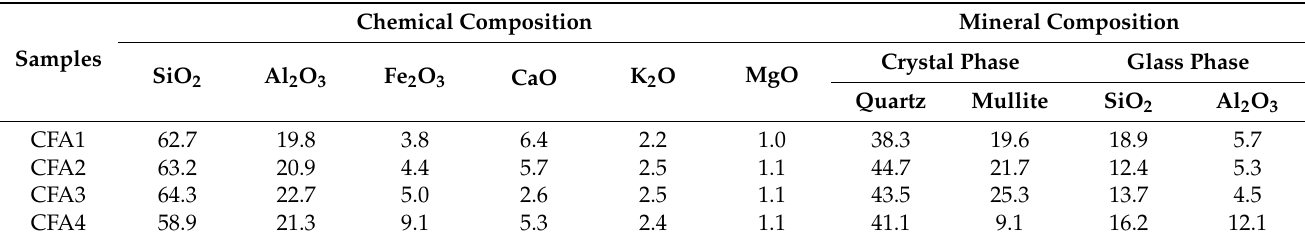
Table 1. Chemical composition (wt.%) and mineral composition (wt.%) of CFAs used in this study. Chemical Composition Mineral Samples